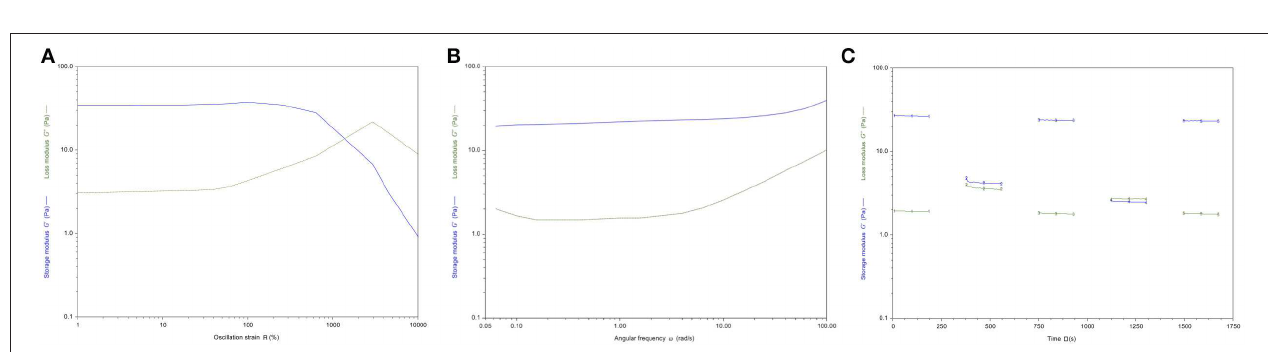
FIGURE 5 | (A) Storage (G ′ , blue) and loss (G ′′ , green) moduli vs. oscillation strain ( γ ) for GE-CH. (B) Storage (G ′ , blue) and loss (G ′′ , green) moduli vs. angular frequency ( ω ) for GE-CH hydrogel. (C) Structural recovery behavior of the GE-CH as a function of time, assessed by monitoring G ′ (t) ( γ 2%, ω 1 rad/s) after destruction by applying an 800% oscillatory shear strain. Modulus G ′ (blue) and G” (green).